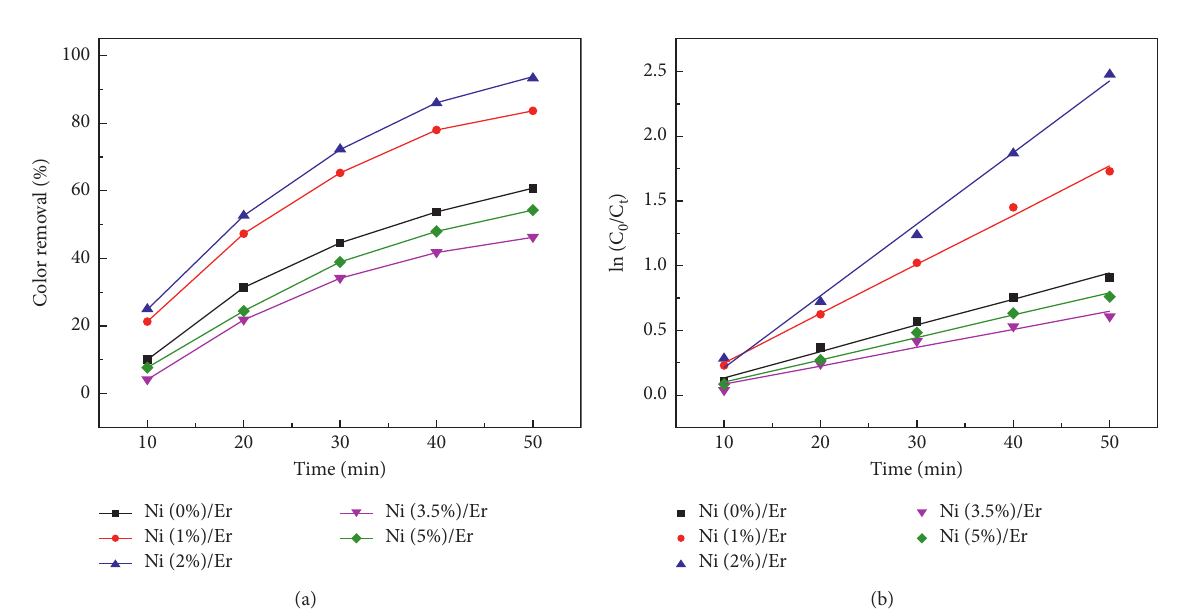
Figure 14: Electrochemical decolorization performance at Ti/SnO 2 -Sb-Ni/Er electrodes modified with various Ni contents. (a) Decol- orization efficiency. (b) Kinetic analysis of the curves (RhB concentration: 40mg · L − 1 ; current density: 10mA · cm − 2 ; supporting electrolyte: 0.1mol · L − 1 Na 2 SO 4 ; 25 °